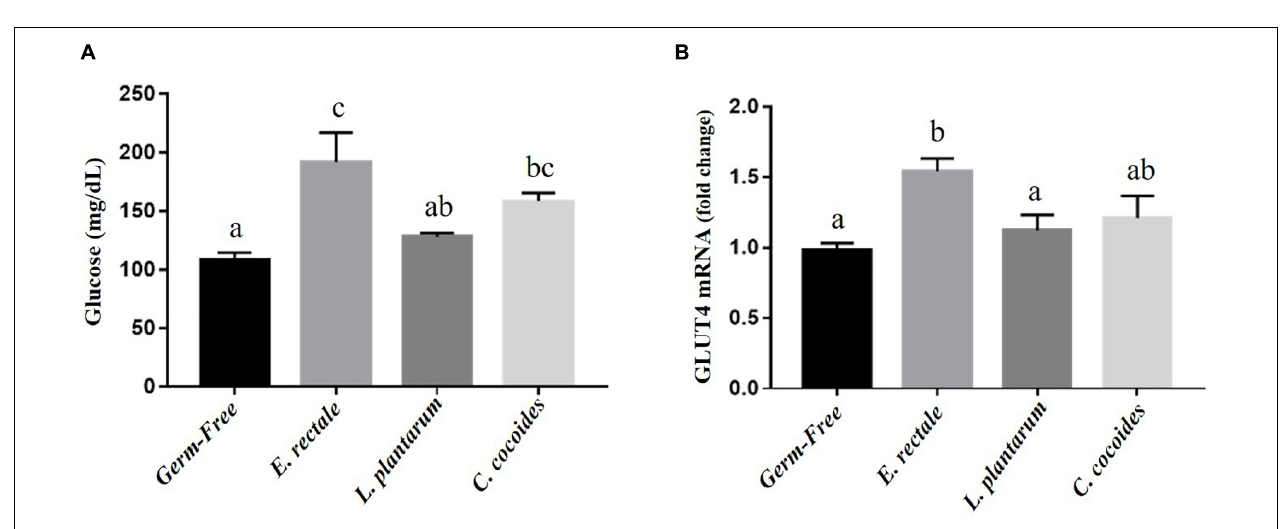
FIGURE 6 | Effect of indicated gnotobiotic groups on the serum glucose (A) after the exercise challenge and muscular GLUT4 expression levels (B) . Data are mean ± SEM ( n = 6–8/group) and the columns with different superscript letters (a,b) are significantly different at P < 0.05.